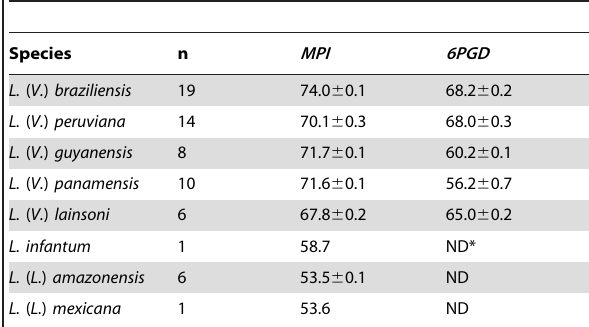
Table 3. Melting temperature ( u C 6 SD) calculated for the melting peaks detected in 65 Leishmania strain